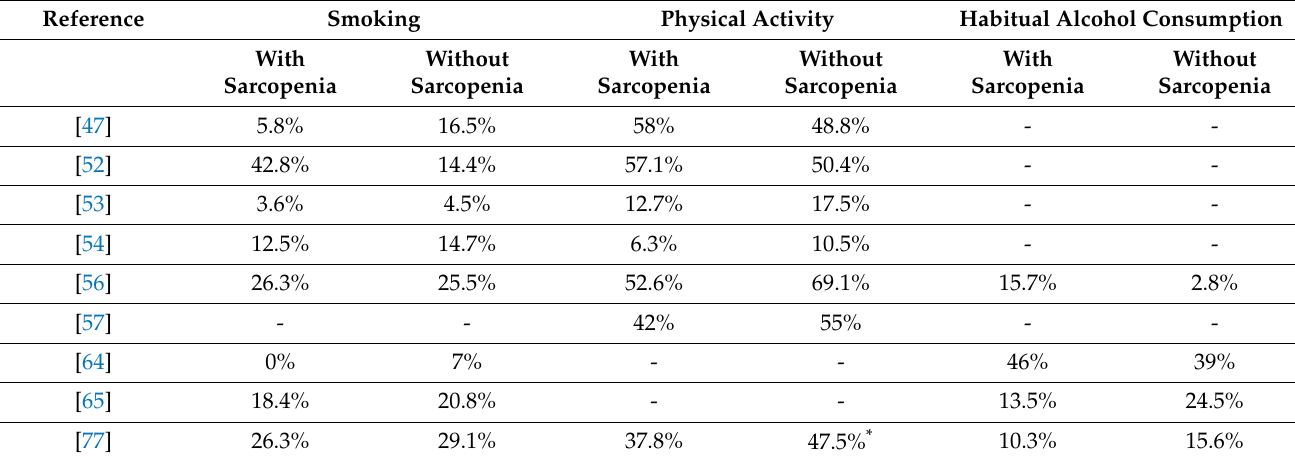
Table 2. Prevalence of lifestyle habits in type 2 diabetes mellitus individuals with and without sarcopenia.